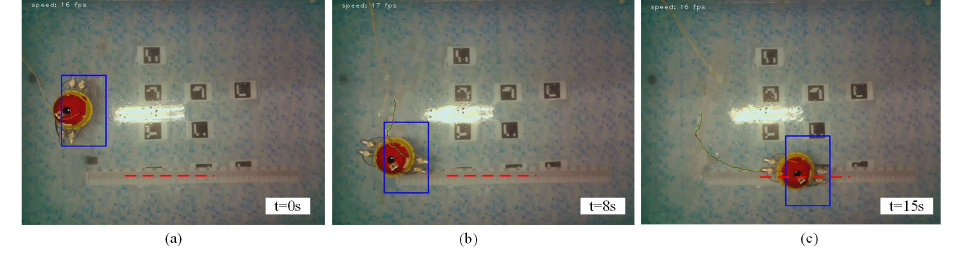
Figure 20. Image sequences of the BSR tracking a line trajectory.